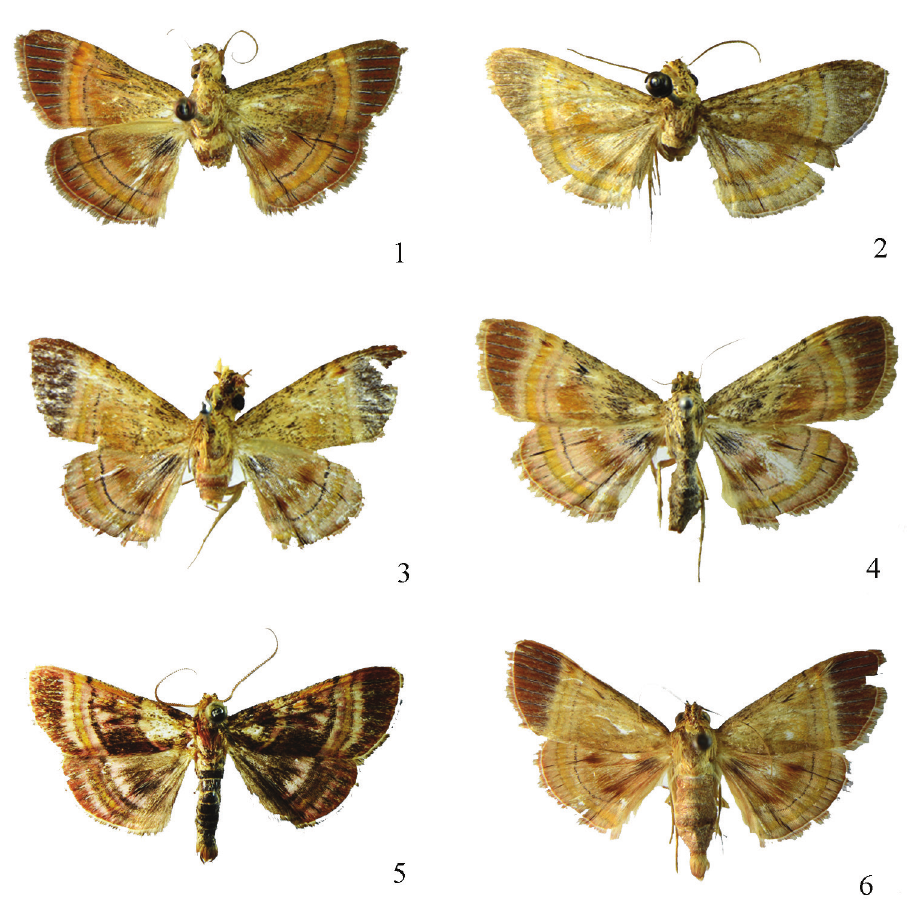
Figures 1–6. Adults. 1 Lista angustusa sp. n., male, holotype 2 L. ficki (Christoph , 1881), male 3 L. gilvasa sp. n., male, holotype 4 L. haraldusalis (Walker, 1859), female 5 L. insulsalis (Lederer, 1863), male 6 L. longifundamena sp. n., male, holotype.